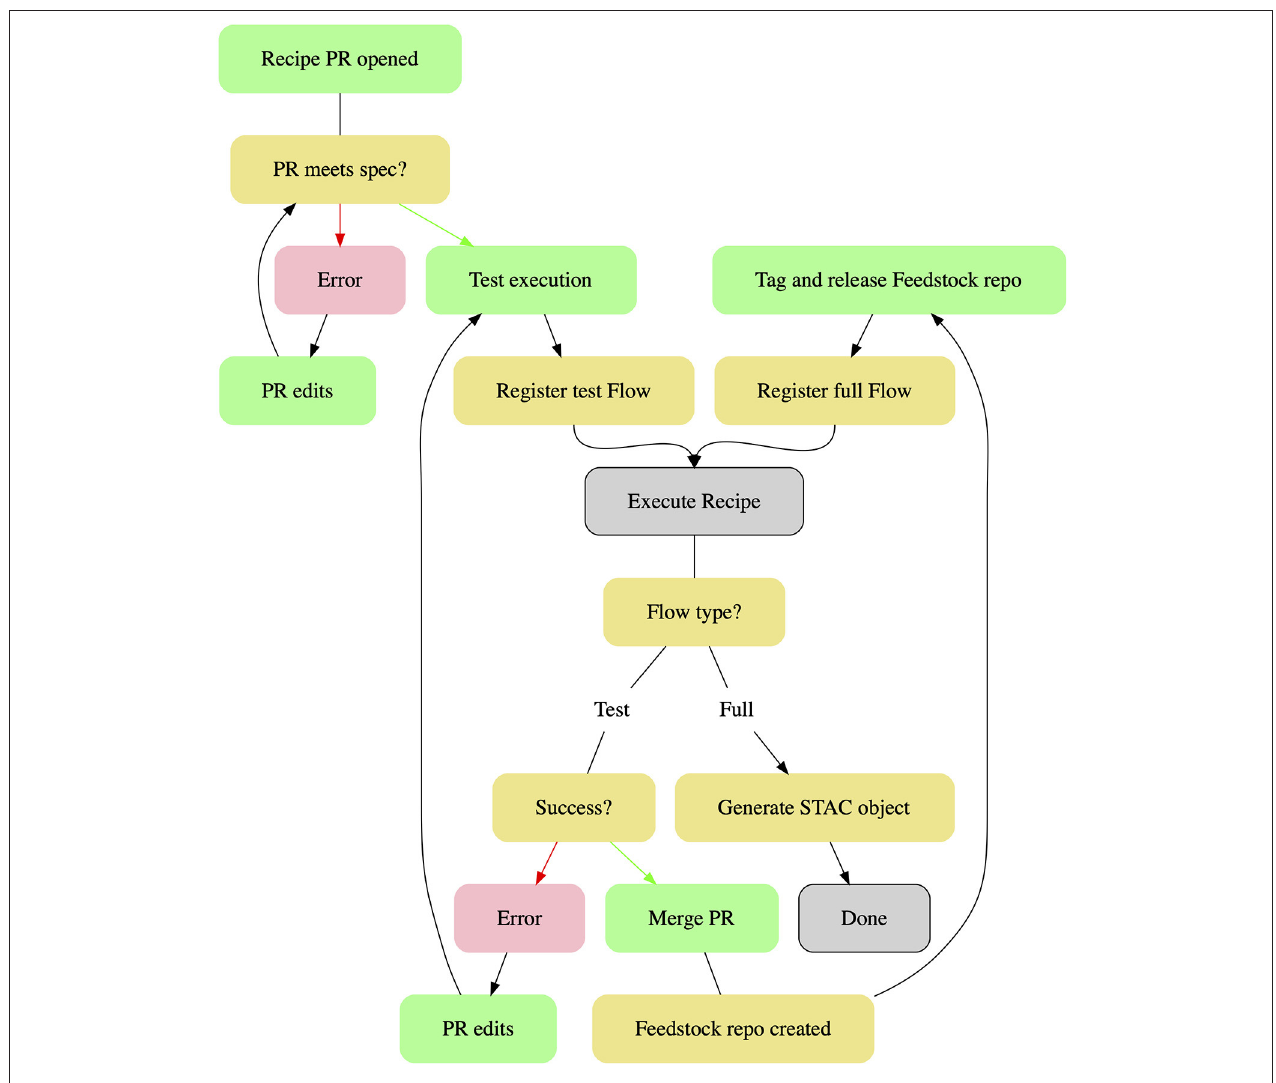
FIGURE 4 | Pangeo Forge contribution